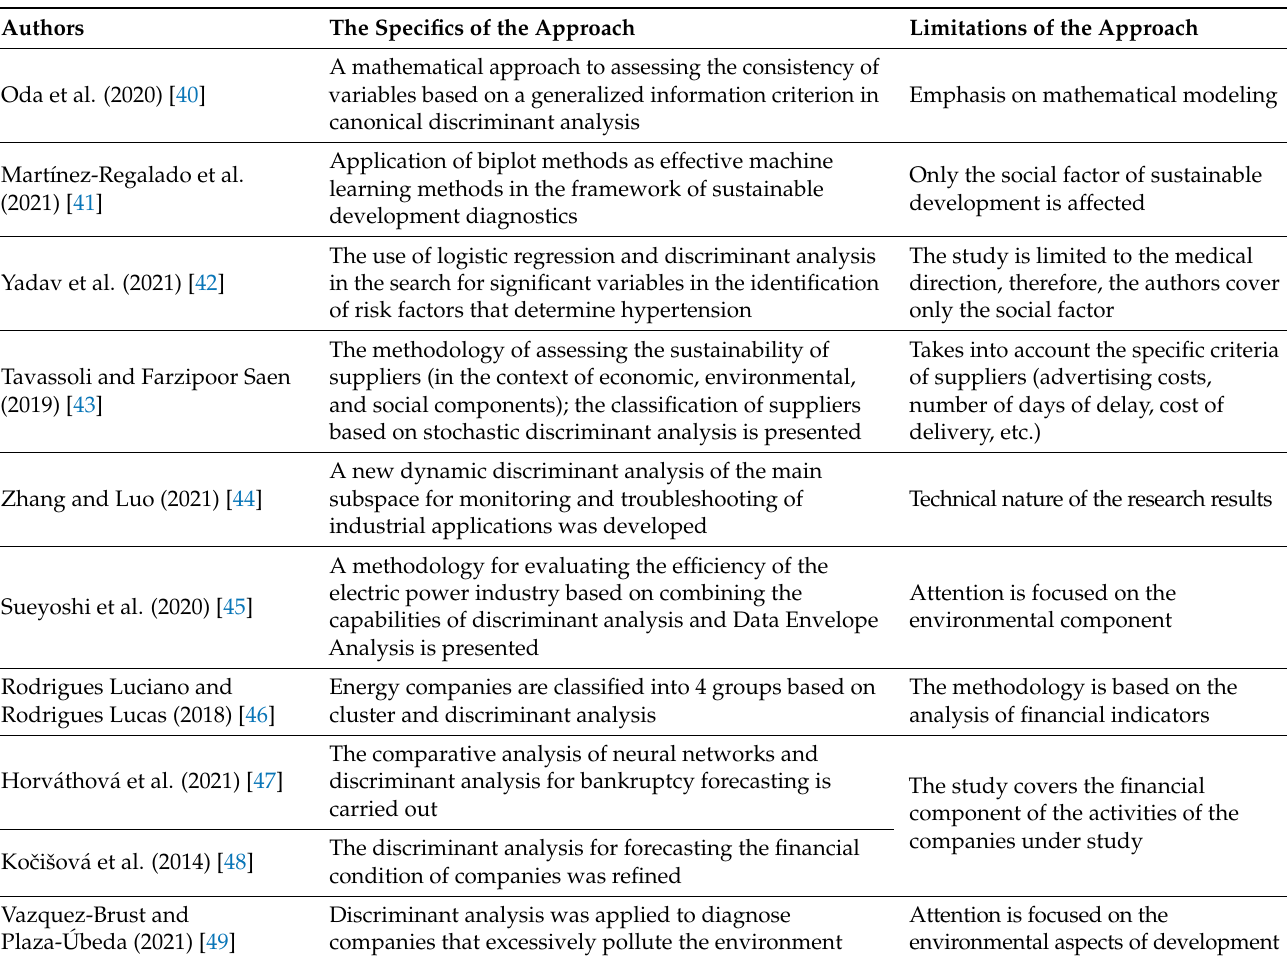
Table 1. Methodological approaches to the diagnosis of sustainable development (compiled by the